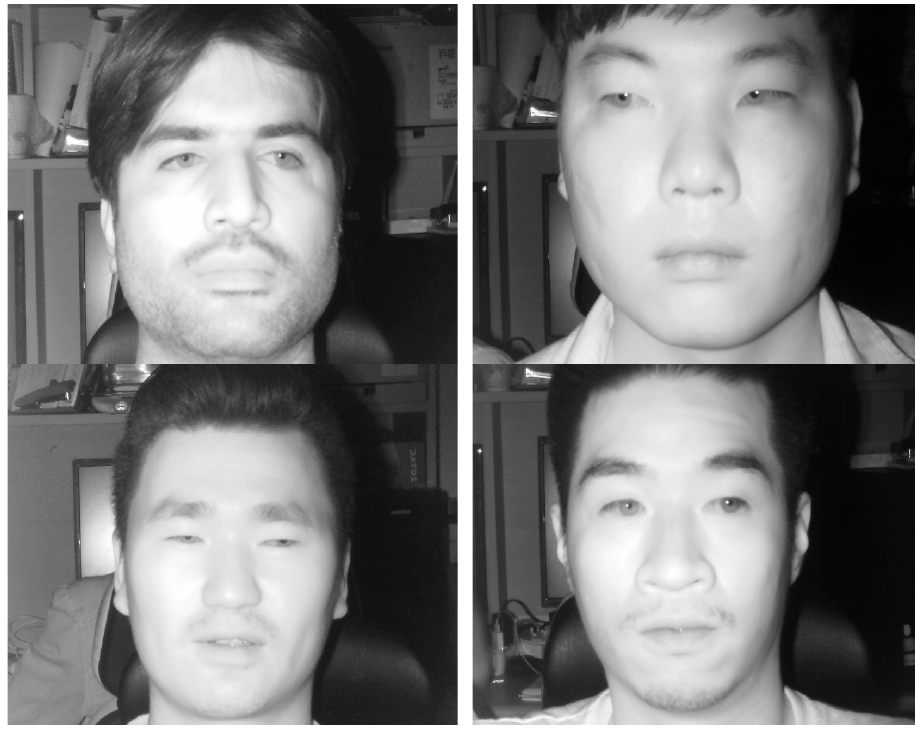
Figure 2 . Experimental environment and proposed prototype for driving behavior classification.